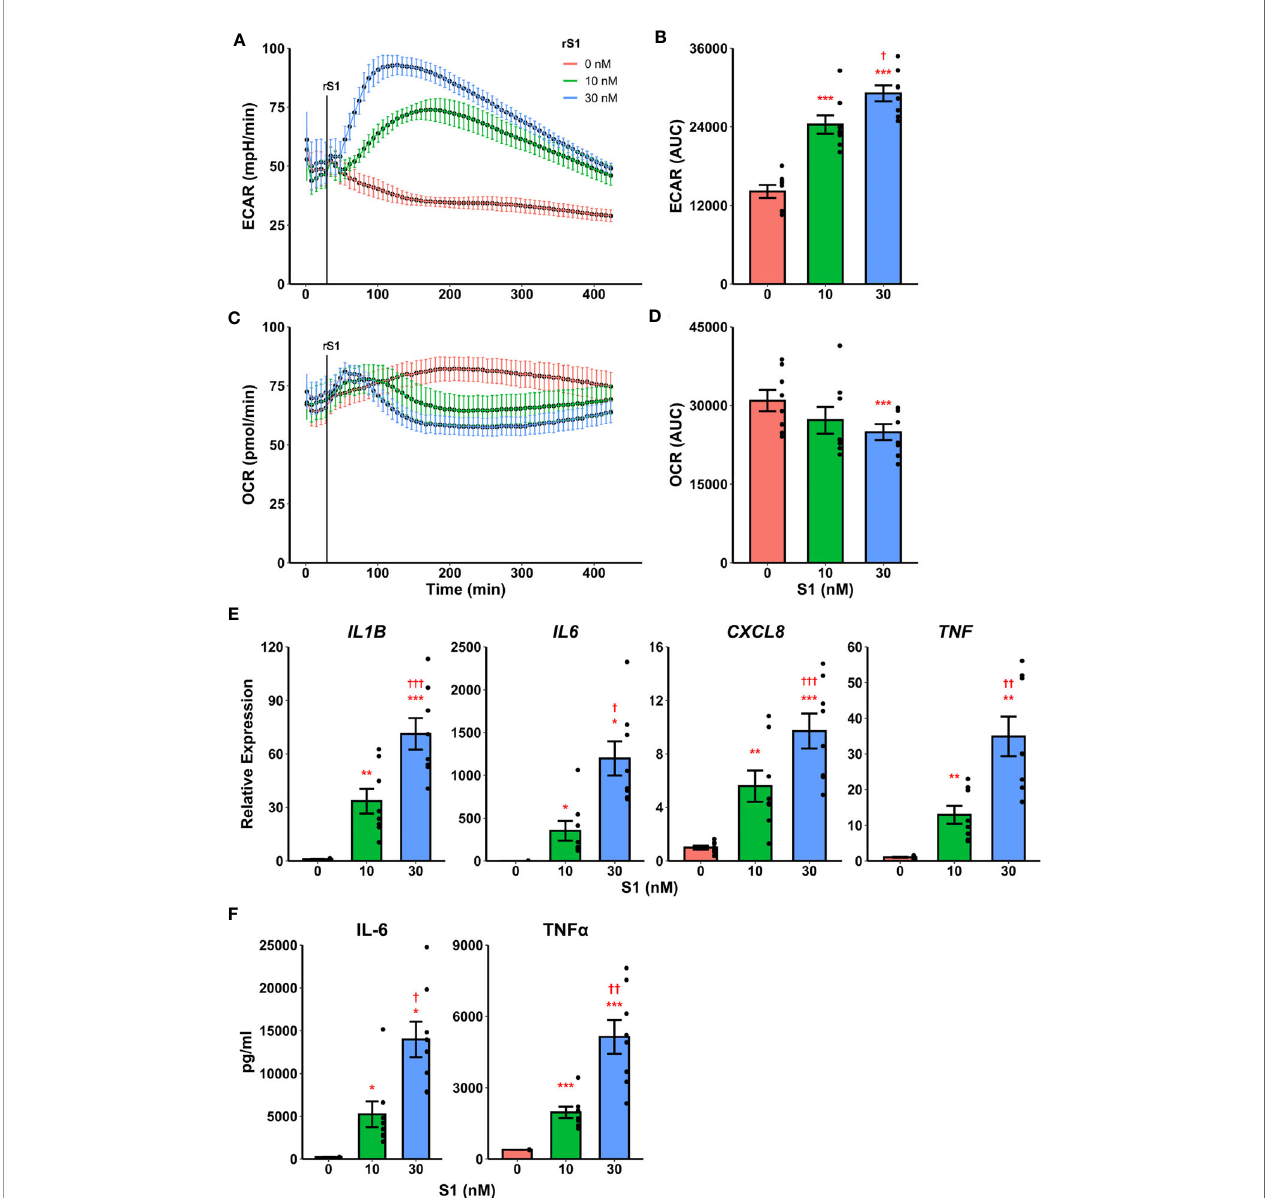
FIGURE 1 | Recombinant SARS-CoV-2 spike protein subunit 1 (rS1) mediates immunometabolic activation of monocytes. (A) Monocytes increase extracellular acidi fi cation response rate (ECAR) in a dose-dependent manner when treated with rS1. (B) Quanti fi cation of ECAR by area under the curve (AUC). (C) rS1 treatment suppresses oxygen consumption rate (OCR) in monocytes in a dose-dependent fashion. (D) Quanti fi cation of OCR by AUC. (E) Gene expression analysis by qPCR reveals dose-dependent increases in responses of IL1B , IL6 , CXCL8 , and TNF to rS1 stimulation. (F) Protein expression analysis by ELISA reveals dose-dependent increases in responses of IL-6 and TNF a to rS1 stimulation. ECAR and OCR data in panels A-D are adjusted for values indexed to 1×10 5 cells/well. *, **, ***p < 0.05, p < 0.01, p < 0.001 vs . 0 nM rS1. † , †† , ††† : p < 0.05, p < 0.01, p < 0.001 vs . 10 nM rS1. N = 8 biological replicates. Bars and error bars are mean ±